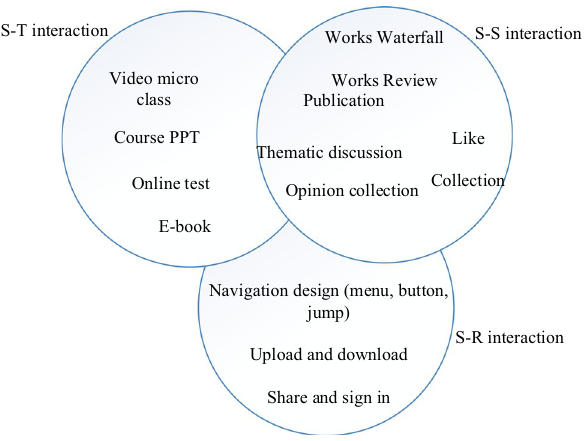
Fig. 4 Interactive function design framework